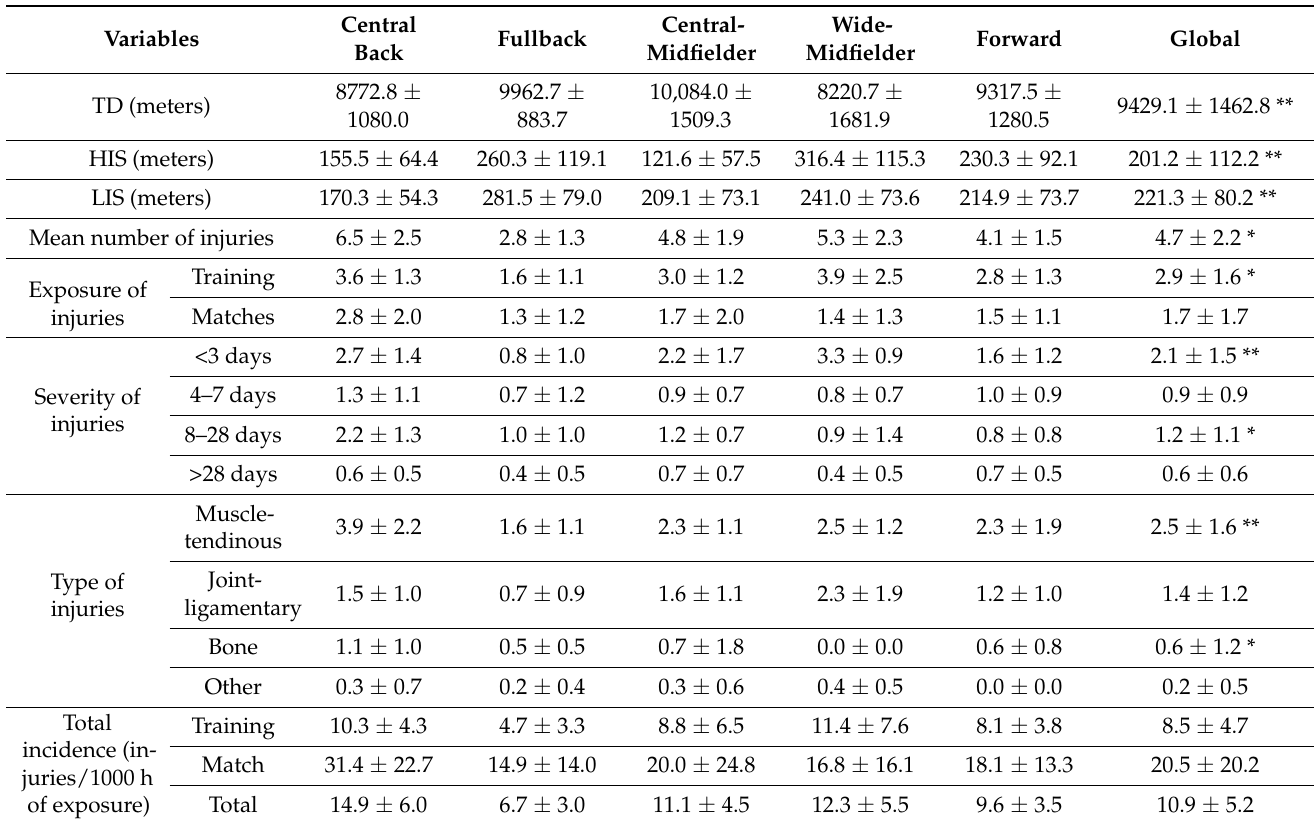
Table 2. Differences in the physical demands variables and injury incidence between the player’s